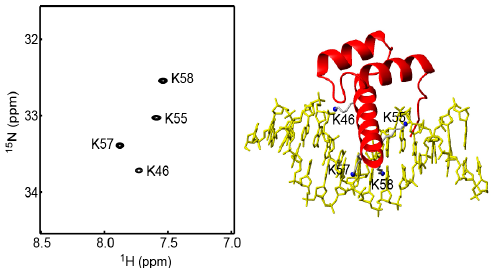
Figure 2. The 1 H- 15 N HISQC spectrum recorded at 15 °C for the NH 3+ groups in the complex of 15 N-labeled Antp homeodomain and unlabeled 15-bp DNA containing a phosphorodithioate at the K46 interaction site. The resonance assignment is based on that for the unmodified DNA complex and unique chemical shift perturbation upon site-specific dithioation (i.e., sulfur substitutions of two non-bridging oxygen atoms) of the DNA phosphate at the K46 interaction site [44]. Table 1. Comparison of 15 N relaxation parameters measured with the previous and current pulse sequences a . Shown below are data for the Lys side-chain NH 3+ groups in the complex of 15 N-labeled Antp homeodomain and unlabeled 15-bp DNA containing a phosphorodithioate at the K46 interaction